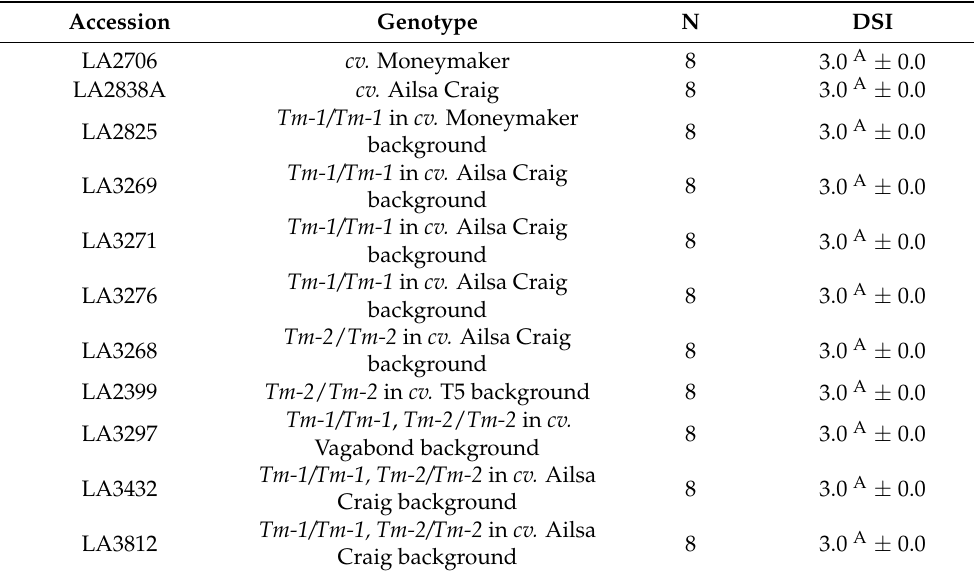
Table 8. Average disease severity index (DSI) of different Tomato Genetics Resource Center (TGRC) accessions carrying Tm-1 , Tm-2 , a combination of Tm-1 and Tm-2 , or no ToMV resistance gene following inoculation with